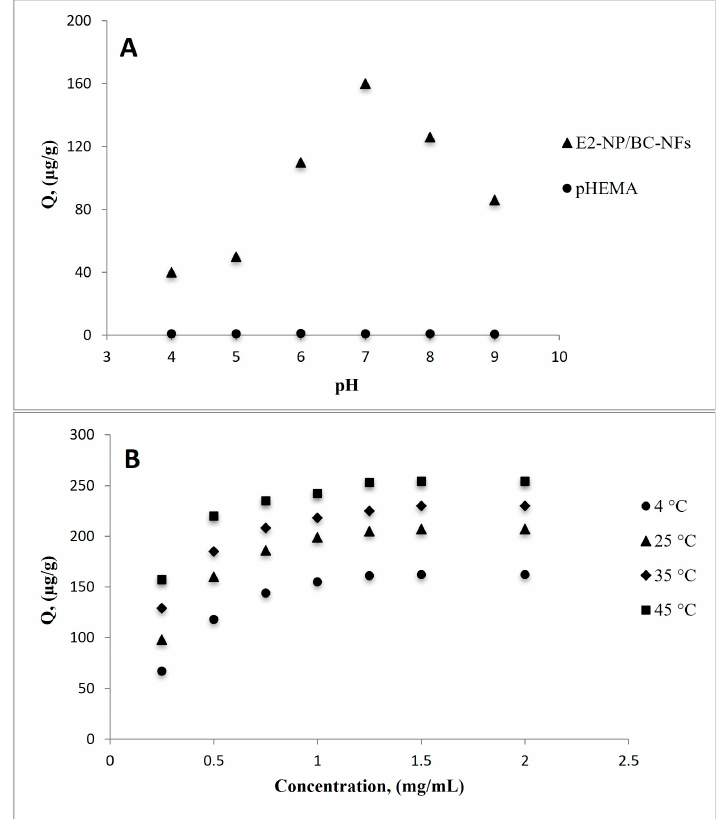
Figure 5. ( A ) The effect of pH on adsorption capacity: ( c 0 : 0.5 mg/mL, IS: 0.0, W particles : 100 mg, t: 25 ◦ C); ( B ) The effect of E2 concentration with different temperatures on adsorption capacity: ( c 0 : 0.5–2.0 mg/mL, pH: 7.0, IS: 0.0, W particles : 100 mg, t: 25 ◦